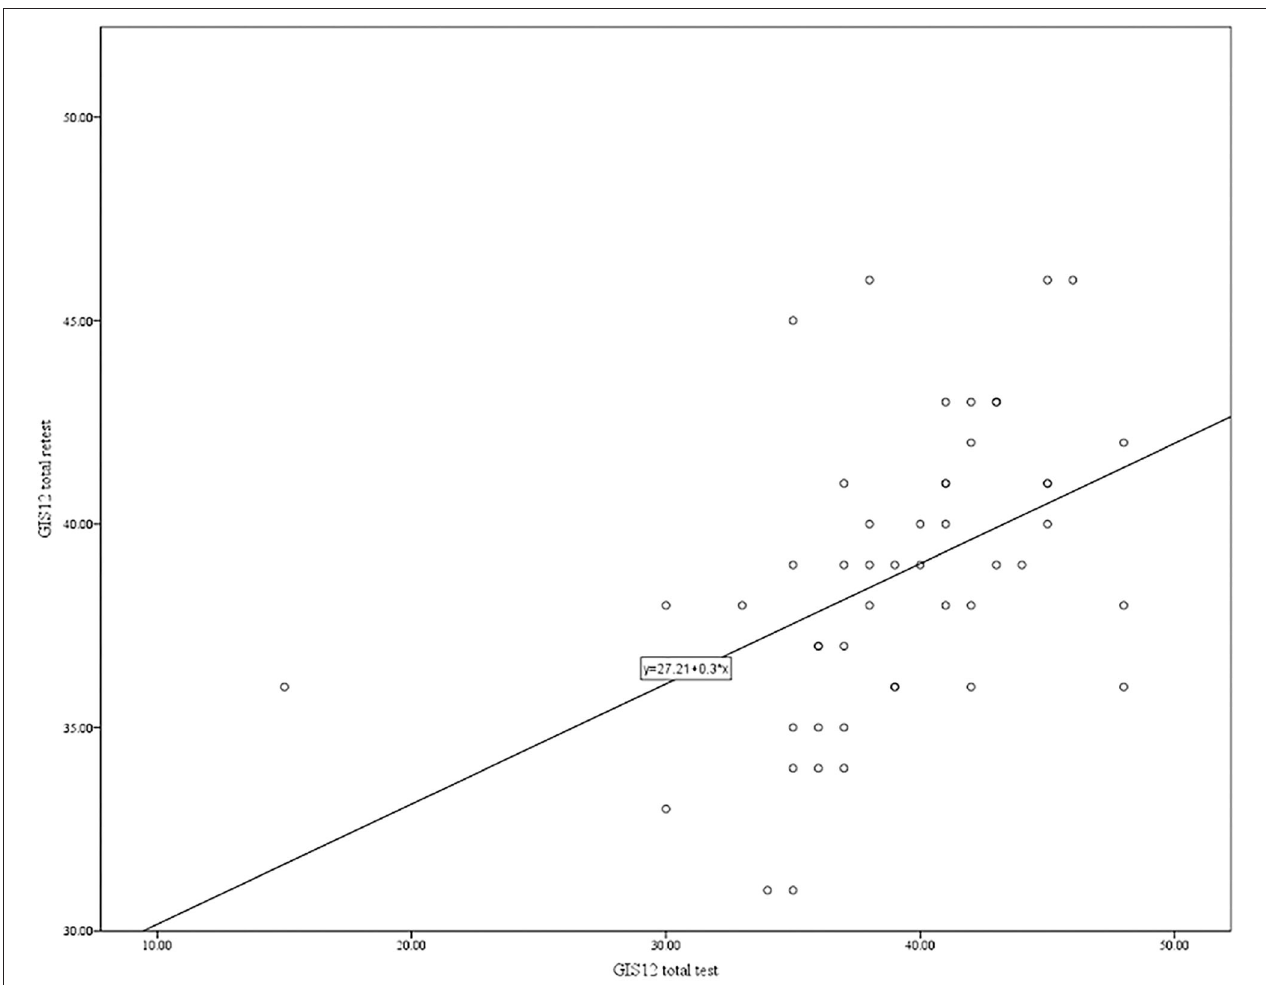
FIGURE 2 | The relationship between the GIS-12 scores obtained at Time 1 and Time